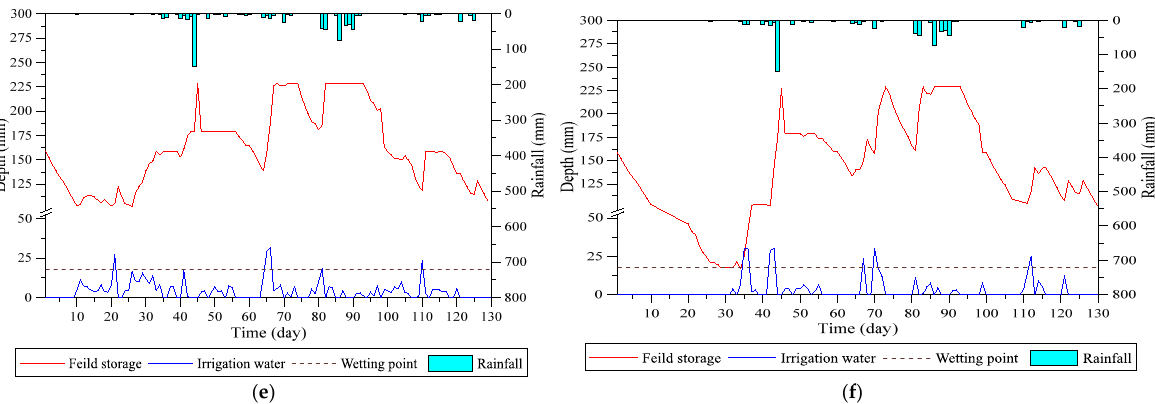
Figure 4. The simulation of a 50% drop of planned irrigation ( a ) and simulation of blocks 1 to 5 ( b – f ).